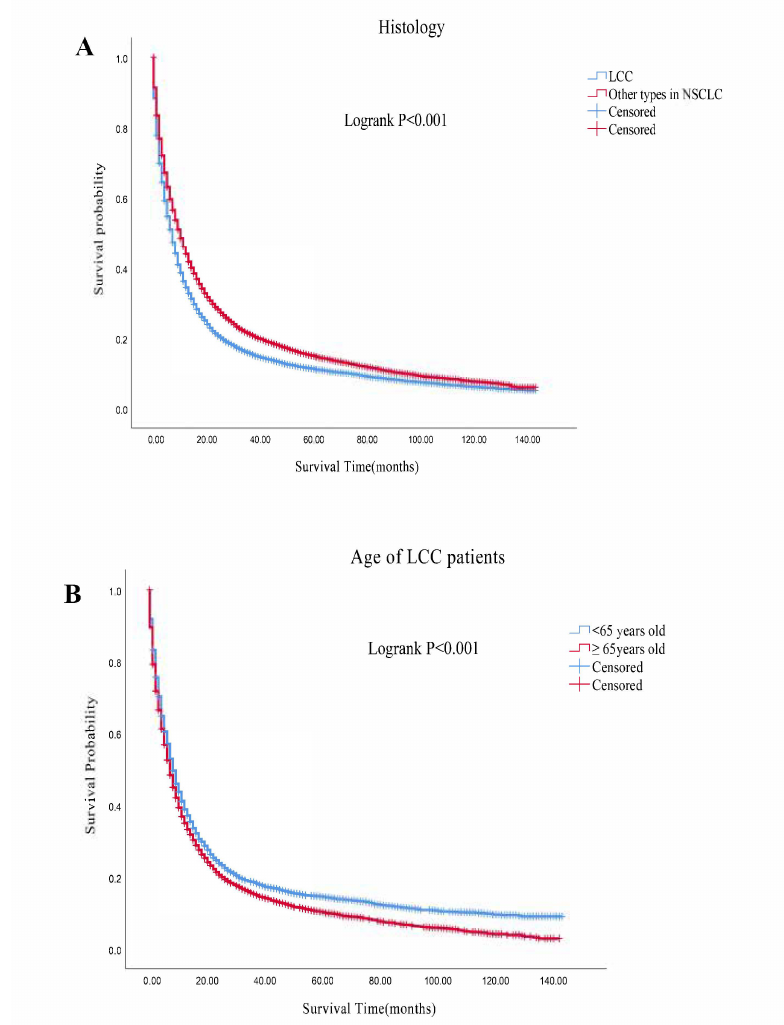
Figure 2. Comparison of survival curves of OS in LCC patients and other types of NSCLC patients ( A ) Comparison between LCC patients and other types of NSCLC patients; ( B ) Comparison between LCC patients <65 years old and ≥ 65 years old. Abbreviations: LCC: large cell carcinoma; NSCLC: non-small cell lung cancer; OS: overall survival. Table 2. Median survival months and 1,3,5-year of OS in LCC and other types of NSCLC